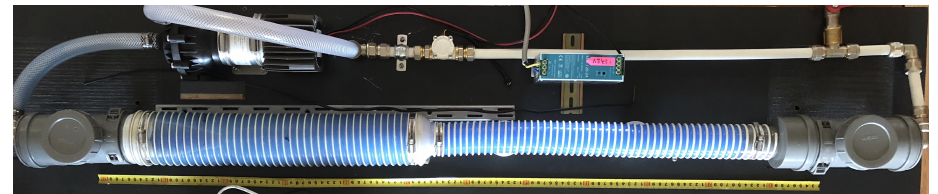
Figure 1. Experimental setup that resembles the cardiovascular system. Fabric conditioner with similar blood characteristics has been used inside the venous system with viscosity of µ = 0.085 × 10 − 5 kg/ms, density ρ = 1.03/100 kg/m 3 , and pulsation frequency ω = 2 π